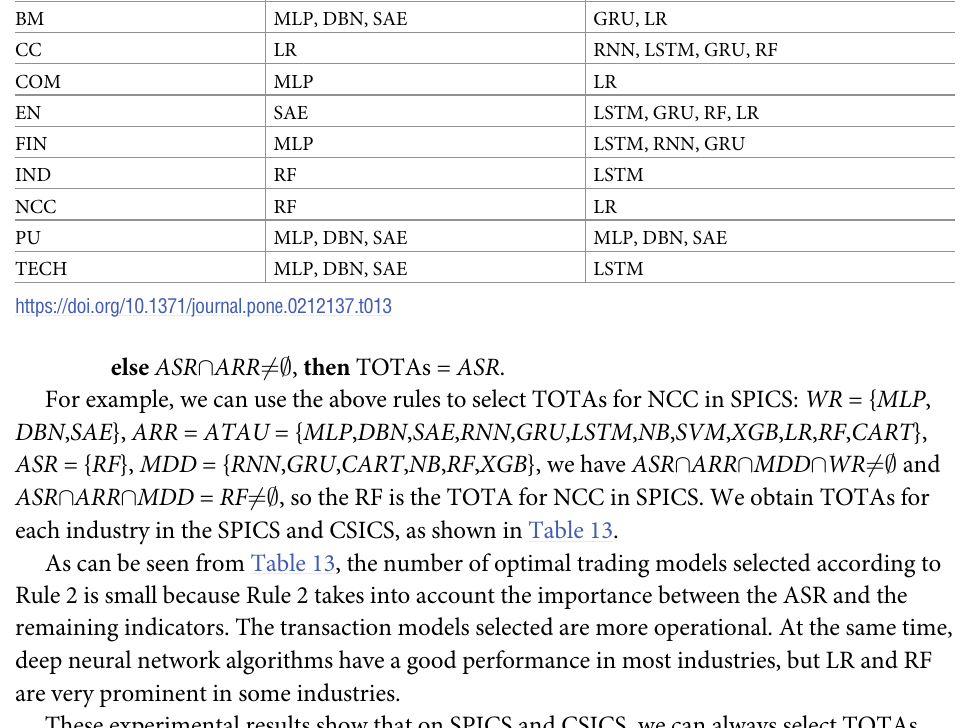
Table 13. TOTAs are selected according to the refining rules.